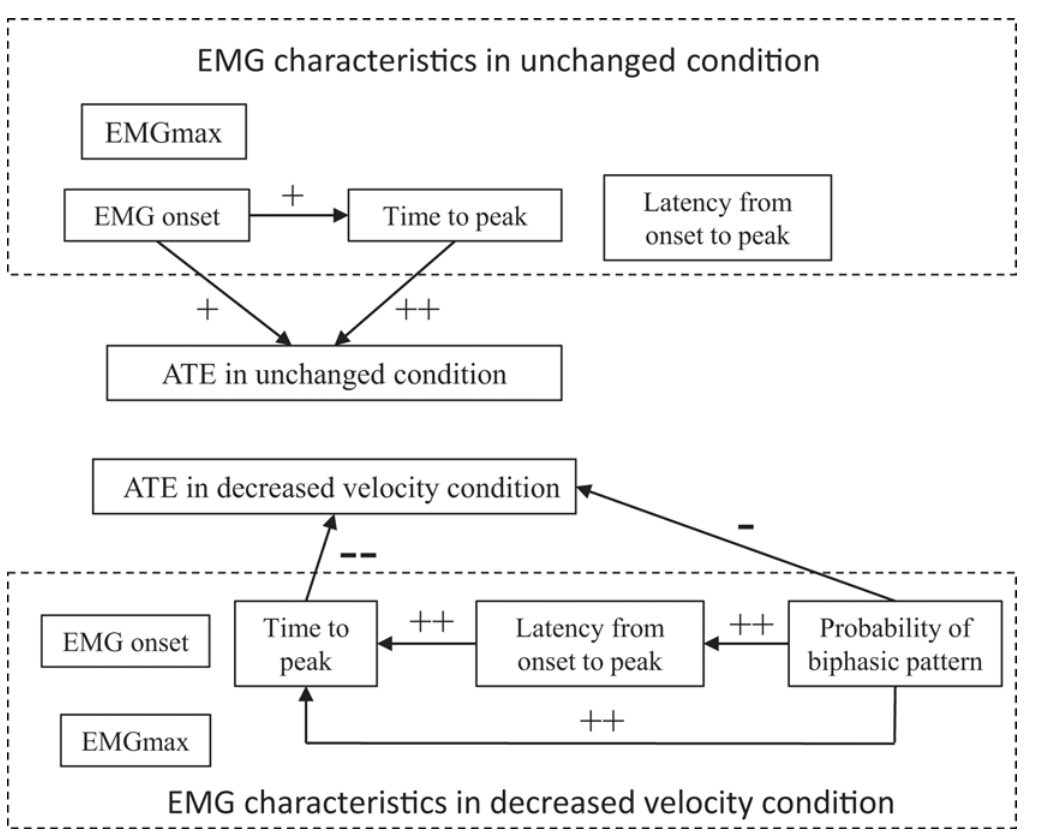
Fig 4. Schematic diagram of relationships between absolute temporal error (ATE) and electromyographic (EMG) characteristics. Relationships: +, positive, p < 0.05; ++, positive, p < 0.01; – , negative, p < 0.01; -, negative, p < 0.05.